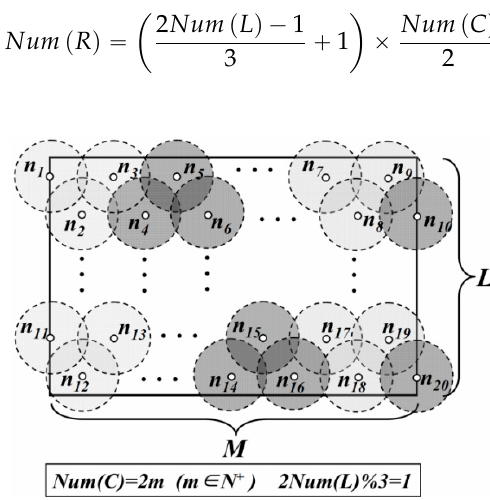
Figure 3. Distribution of DGAs ( Case 2 ).